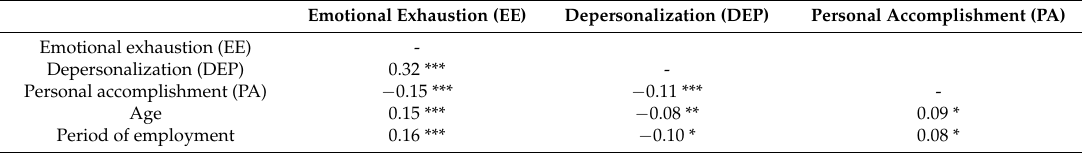
Table 3. The matrix correlation between dimensions of burnout and age and period of employment. Emotional Exhaustion (EE) Depersonalization (DEP) Personal Accomplishment (PA) Emotional exhaustion